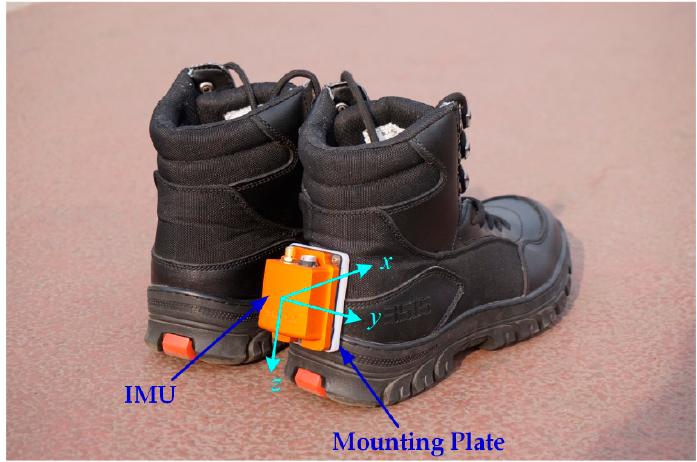
Figure 2. Pedestrian navigation shoe based on the IMU.